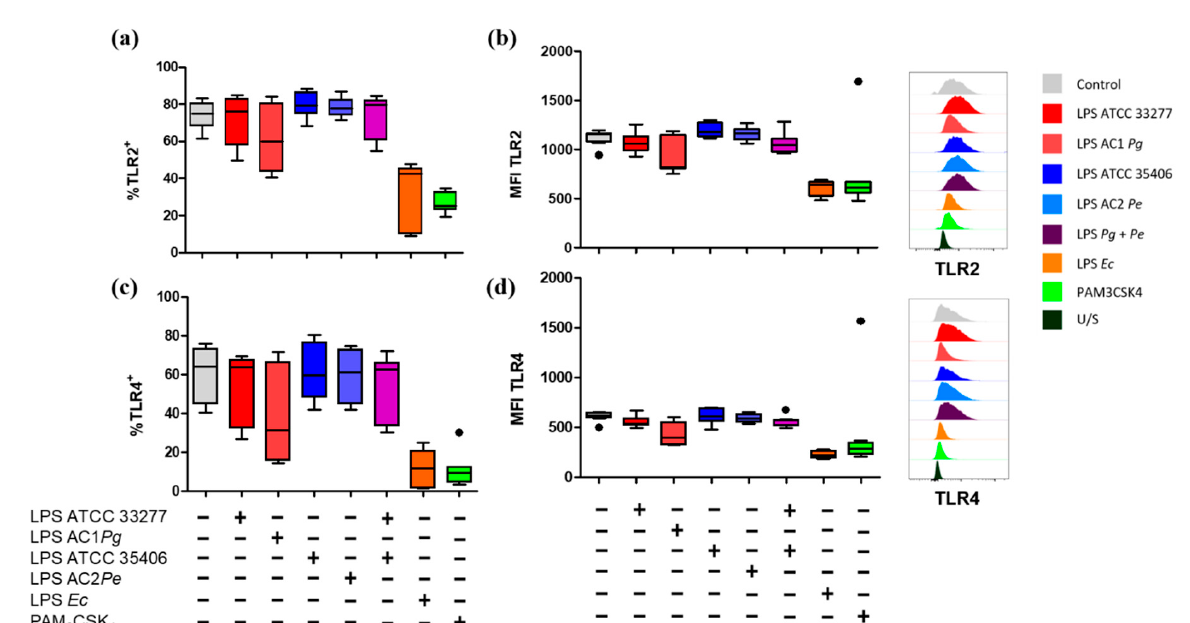
Figure 4. Percentage of single stain and expression levels of TLR2 and TLR4 in LPS or lipopeptide- stimulated macrophages in vitro. Box and whisker plots represent the median and interquartile range of ( a ) TLR2 + and ( b ) TLR4 + percentage. ( c ) Mean fluorescence intensity (MFI) of TLR2 and ( d ) TLR4 of THP-1 macrophages in vitro stimulated for 24 h with LPS or PAM 3 CSK 4 . U/S Unstained. Experi- ments were performed in triplicate. Data were analyzed by the Kruskal-Wallis test. ( • ) Represents outlier data. ( n =